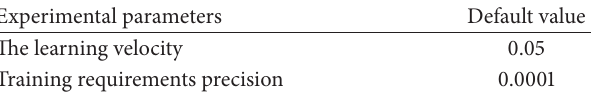
Table 2: Experiment parameters of RBF. Table 3: Comparison between RBF, GRNN, and SVR and FOARBF, FOAGRNN, and FOASVR forecast for wind speed in four